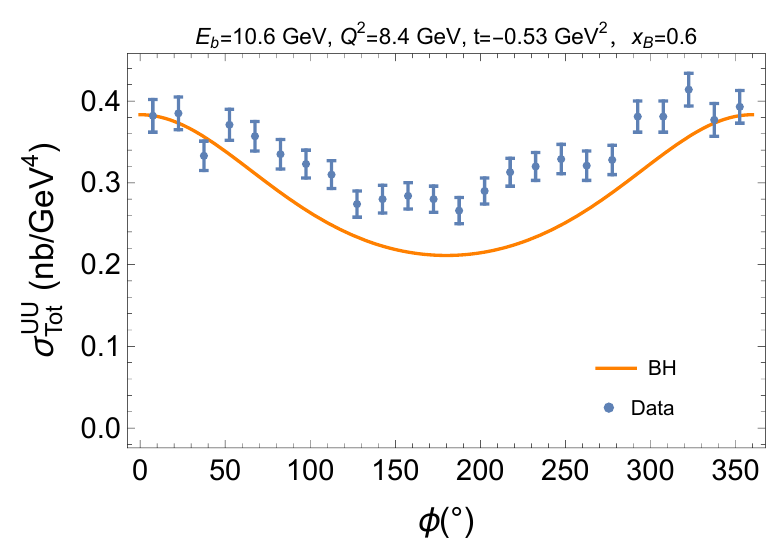
Figure 2. Data points for σ UU from one particular bin of data from [37, 38]. Shown also is the calculated Bethe-Heitler cross section (using the results of appendix D) at the same